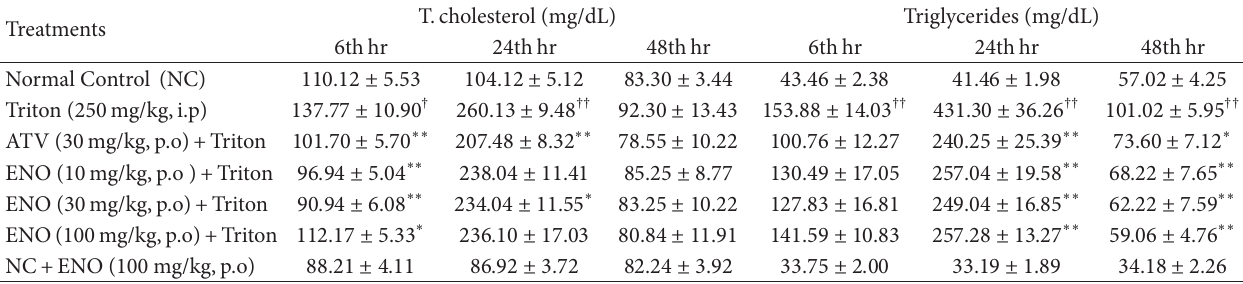
versus triton-treated rats and NC+ENO-treated rats—